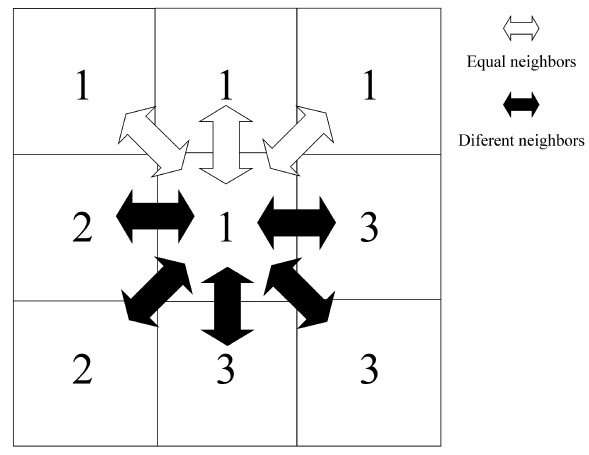
Figure 4. Stability of a triple point, with three 120° angles. A reorientation attempt to Q = 3 would lead to the same free energy value (G = 5). An attempt to Q = 2 would result in a greater value (G = 6), not favorable. Hence this configuration is stable, unless for statistical